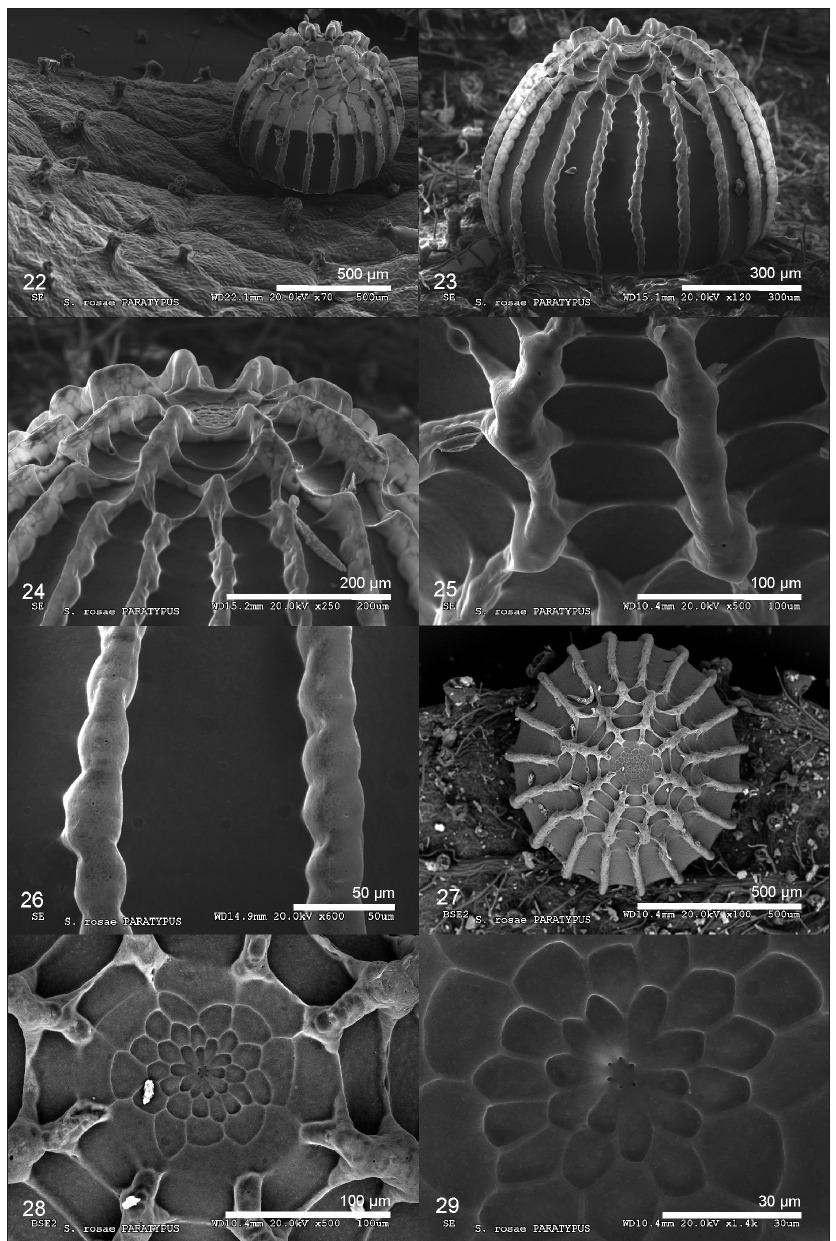
Figures 22–29. Scanning electron microscope images of the egg of Spialia rosae (Paratypes from Puerto de la Ragua, Granada, SE Spain). 22. Lateral view of egg on a leaf of Rosa sicula showing the glands of the plant epidermis. 23. Lateral view. 24. Lateral view of the annular area with annular area in the middle. 25. Cells from the lateral zone of the egg formed by radial and transverse ribs. 26. Detail of the radial ribs. 27. View of the annular pole. 28. Annular area with the micropylar rosette. 29 . Detail of the micropylar rosette and the micropyle showing six micropylar